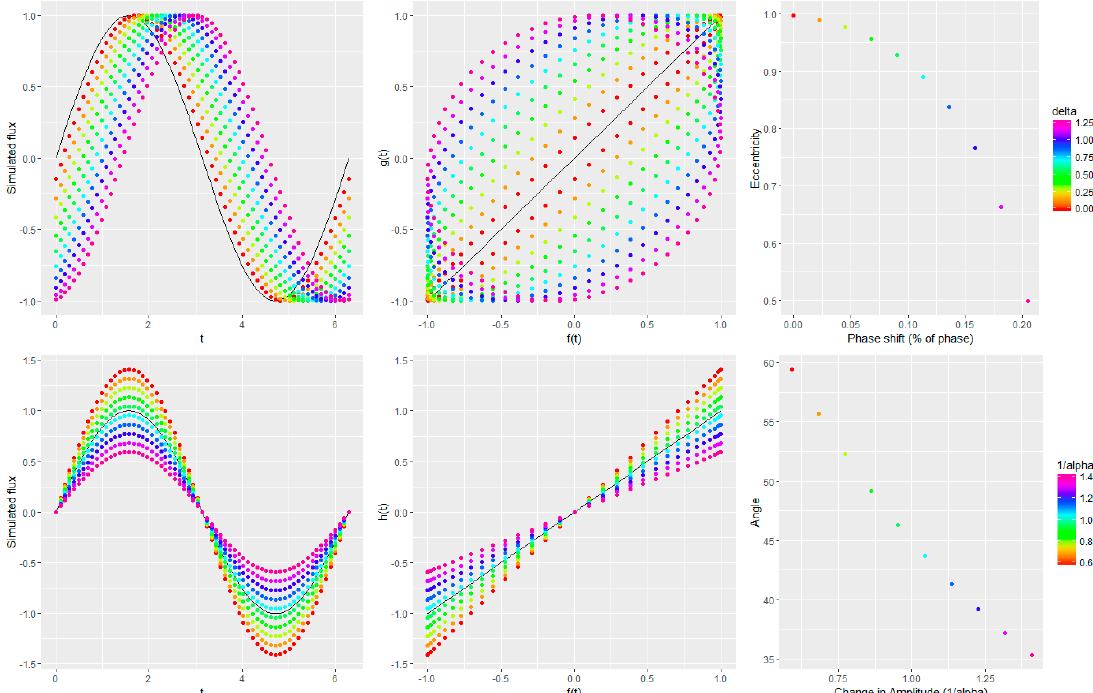
Figure 4. Idealized system parametric functions and incremental changes in modified response functions are shown for phase shift ( upper ) and magnitude ( lower ). Left: The input function is shown in black, with incremental changes in the response functions shown in colors. Center : The original, unmodified function is plotted against the modified response function. Right: The phase shift is related to eccentricity, and magnitude is related to angle.